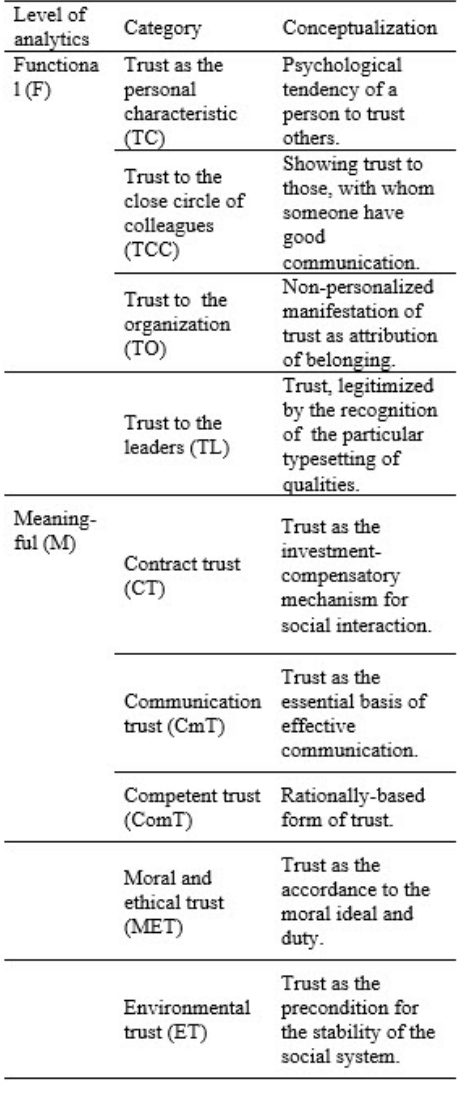
Table 1. The dimensions of